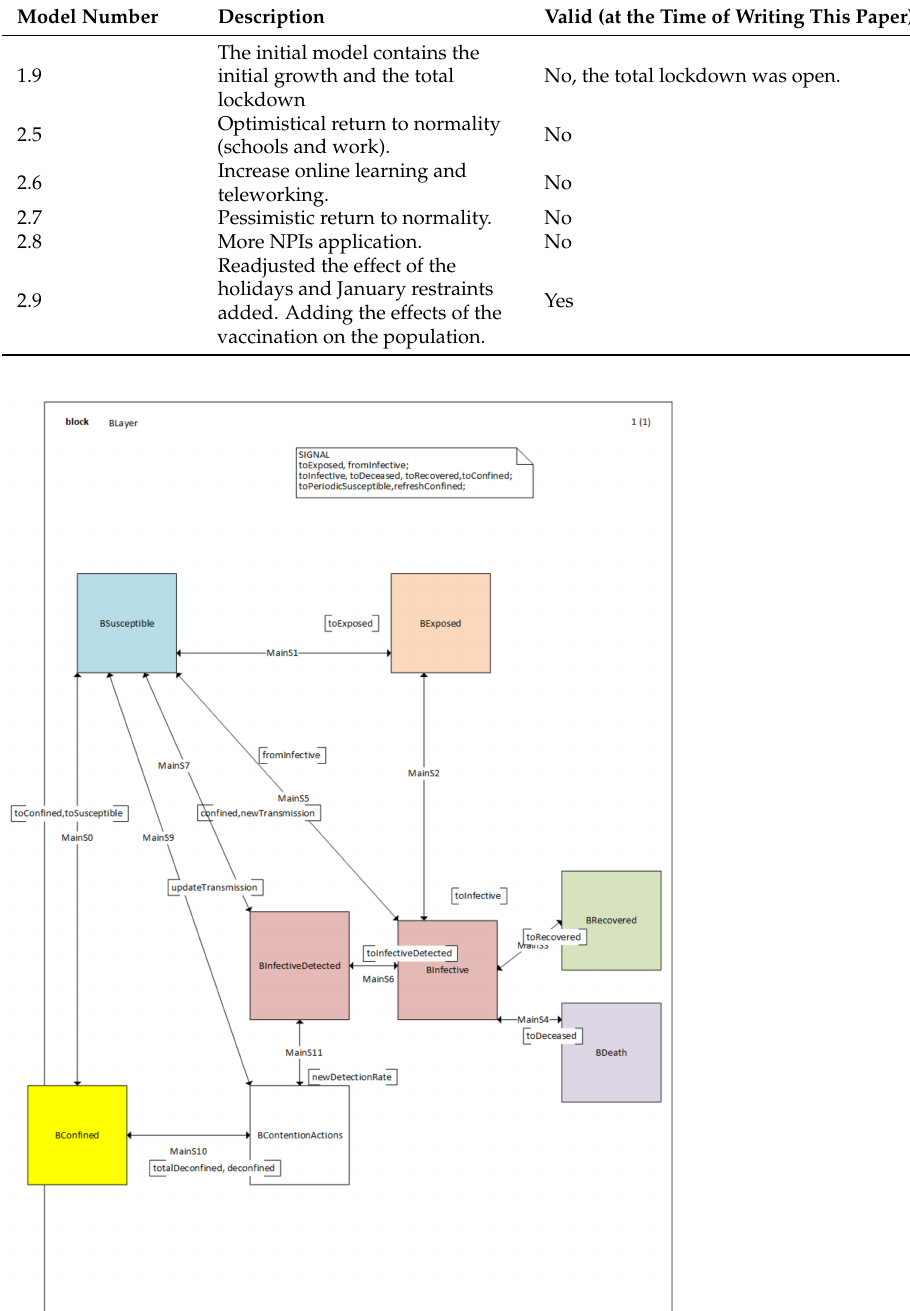
Table 1. Models defined on the frame of the digital twin Catalonia’s pandemics modeling process.